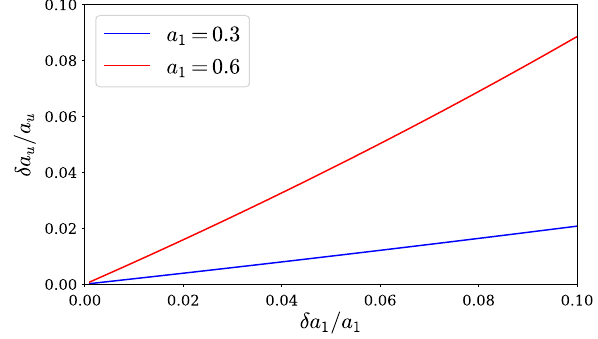
FIG. 4. The normalized momentum u dashed line: analytical result from Eq. (18); Blue solid lines: numerical results obtained for an electron beam by solving the transverse momentum equation with the electric field in Eq. (7).